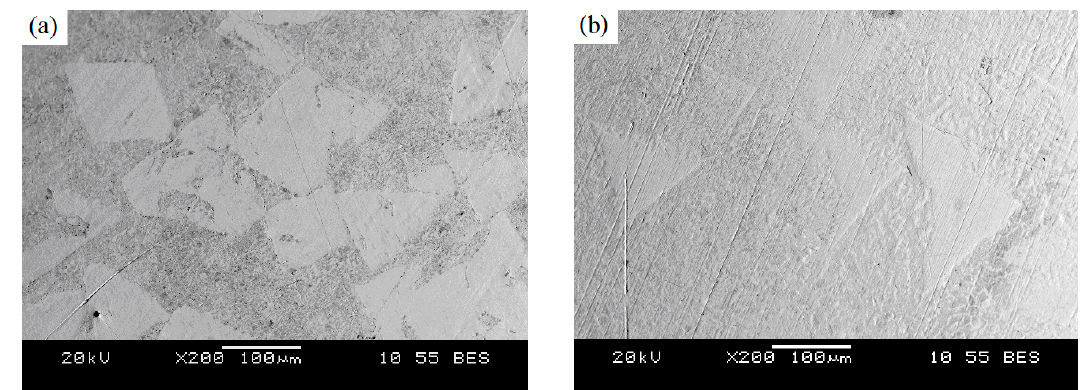
Figure 6. Microstructure of the Bi-38Pb sample ( a ) without EMP treatment and ( b ) after EMP processing.